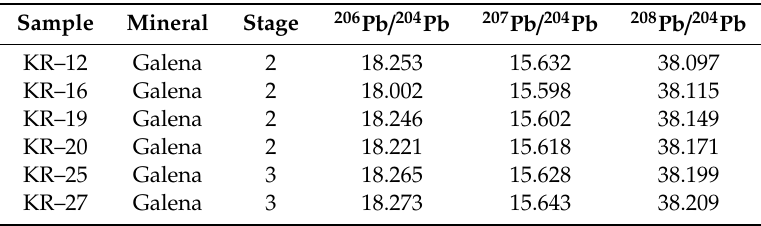
Table 4. Lead isotope data for galena from the Kuergasheng Pb–Zn